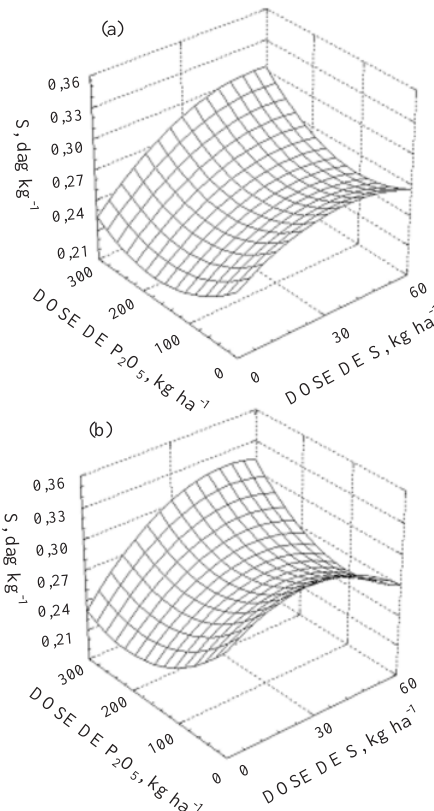
Figura 3. Superfície de resposta, relacionando teores de enxofre no tecido foliar da soja (y), função da aplicação de doses de fósforo (x) e doses de enxofre (z) para as fontes: (a) fosfato natural reativo yˆ = 0,229729 – 0,000383544 P + 0,00245964 ** S + 0,00000136647 * P 2 – 0,000026885 0 S 2 (R 2 = 0,54 ** ) e b) superfosfato triplo yˆ = 0,283781 – 0,000625242 ** P + 0,00196238 S + 0,00000148645 * P 2 – 0,0000365502 * S 2 + 0,00000529256 * PS (R 2 = 0,67 ** ); o , * , ** = coeficientes da equação significativos a 5 e 1 %,